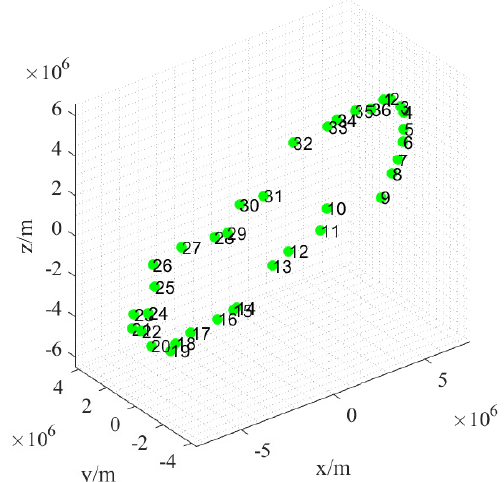
Figure 12. The final distribution of the coplanar satellites in the geocentric inertial